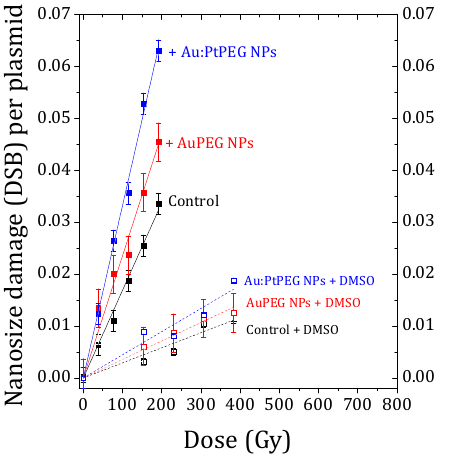
Figure 5. The number of complex damage in the control ( (cid:4) ) and samples in the presence of Au-PEGNPs ( (cid:4) ) and Au:Pt-PEG NPs ( (cid:4) ) as a function of the irradiation dose. The average number of nanosize damage when DMSO is added to the control ( (cid:3) ) and samples loaded with Au-PEG NPs ( (cid:3) ) and Au:Pt-PEG NPs ( (cid:3)